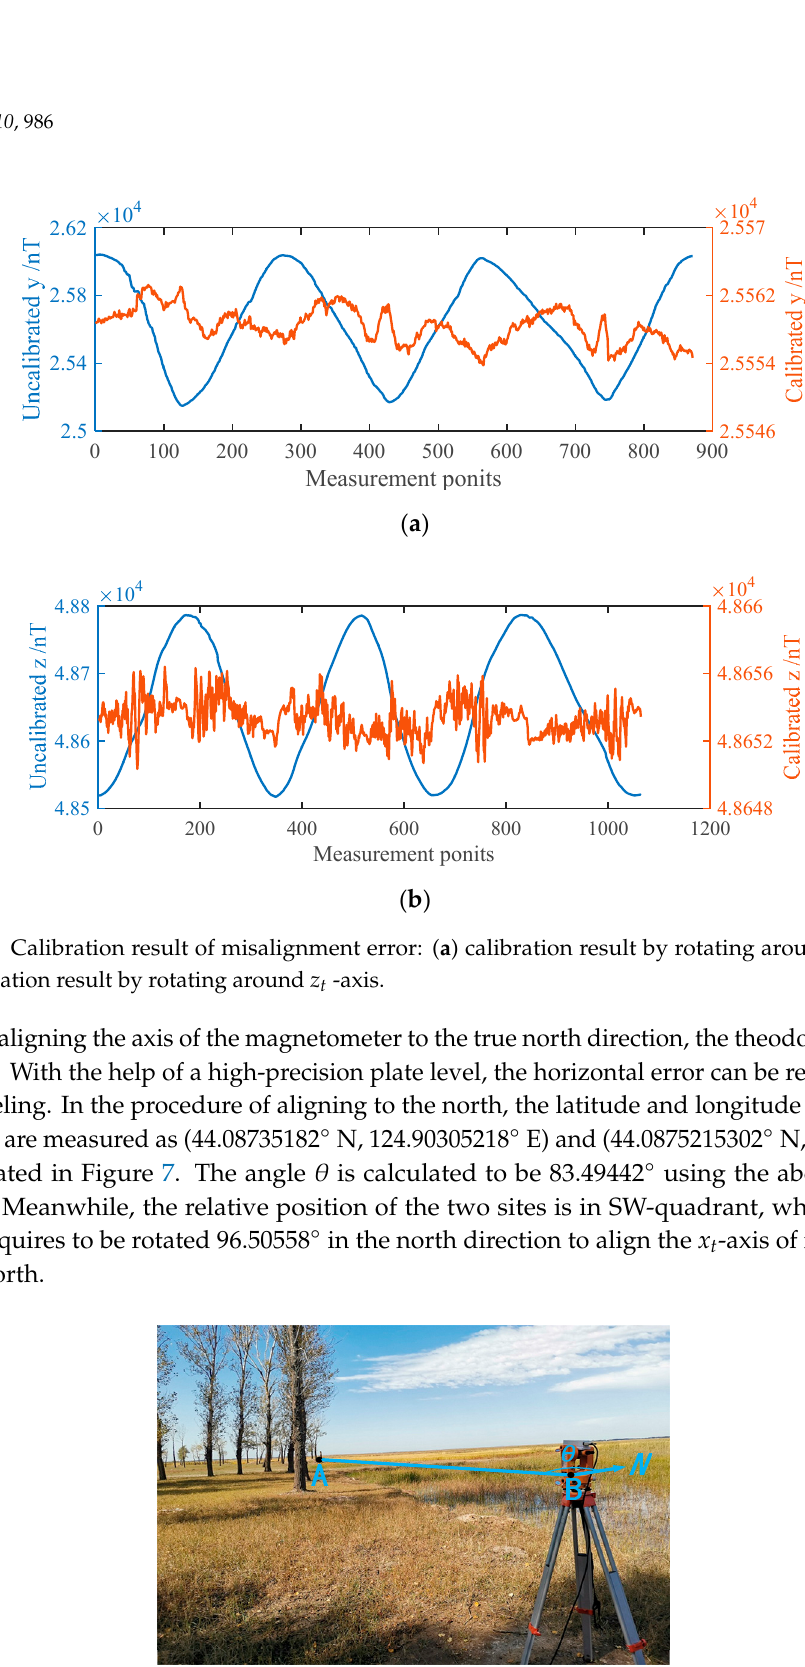
Figure 7. Diurnal variation observation